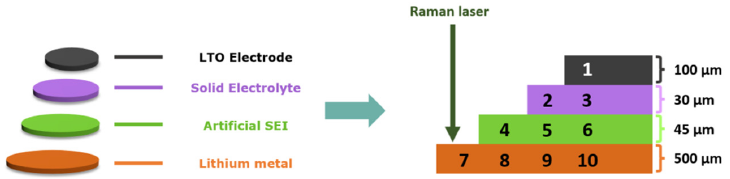
Figure 1. The layers constituting the step-like system, and the subsequent assembly in this mode with layer thickness shown.